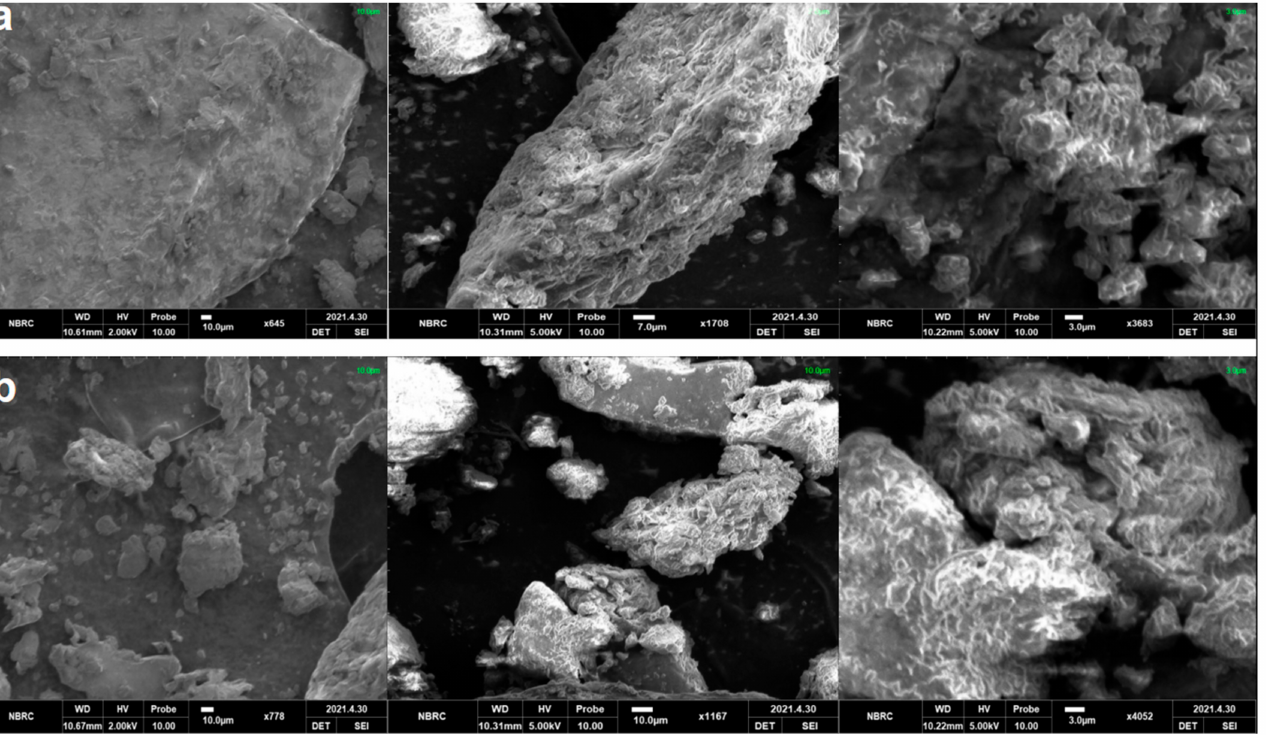
Figure 3. SEM microstructures: ( a ) FAXs extracted from NMB ( b ) FAXs extracted from